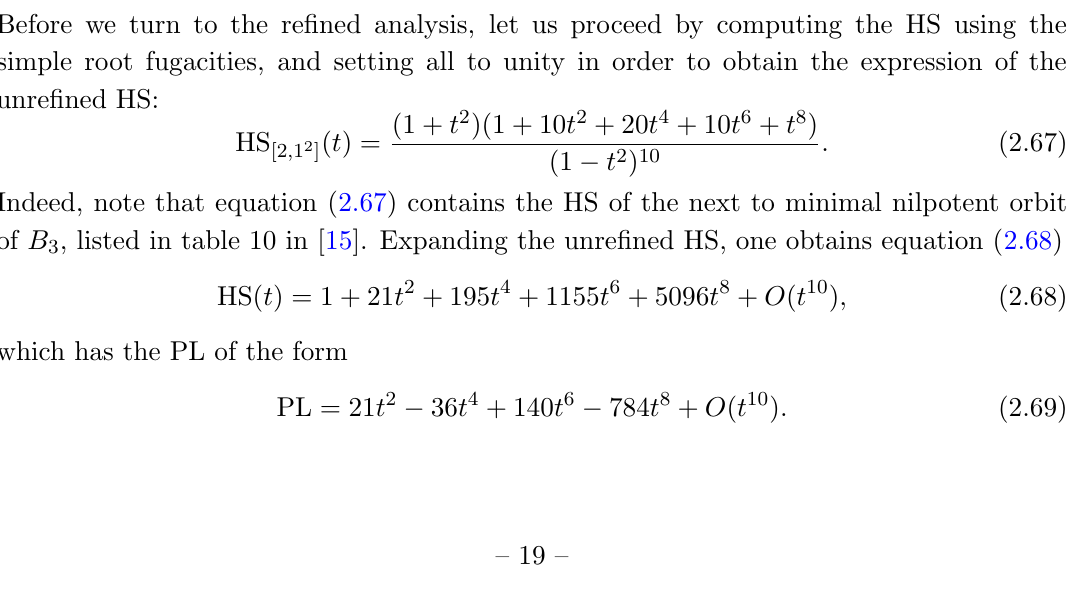
Figure 13 . Dynkin diagram of the a(cid:14)ne B 3